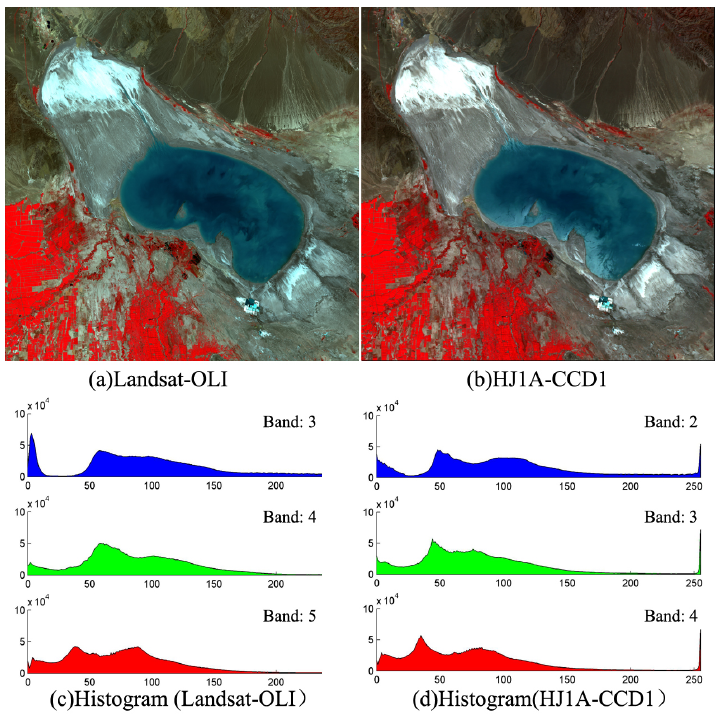
Figure 9. Reflectance images and histogram graphs of the original remote sensing data.